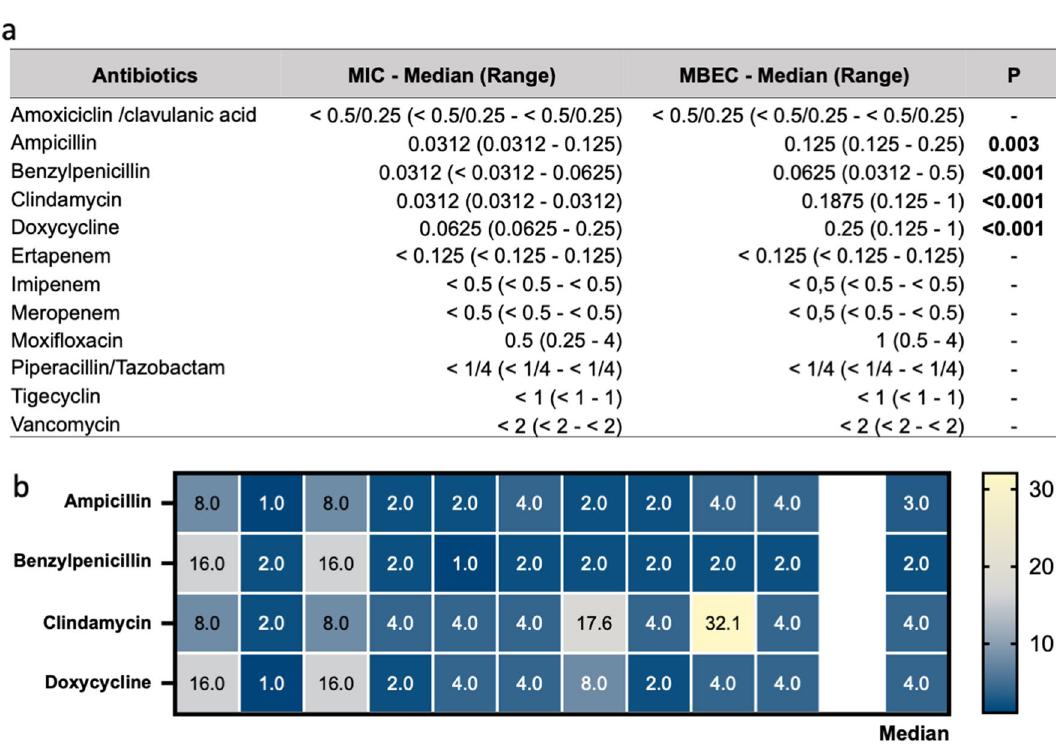
Figure 6. Antimicrobial tolerance in C. acnes isolates. ( a ) Antimicrobial susceptibility testing against ten C. acnes strains (phylotype IA1) isolated from the lesional skin of acne patients in planktonic and biofilm growth measured as minimum inhibitory concentration (MIC) and minimal biofilm eradication concentration (MBEC) for the indicated antibiotics. ( b ) Heat map showing the biofilm tolerance (BT), calculated as the ratio MBEC/ MIC for ampicillin, benzylpenicillin, clindamycin, and doxycycline. Yellow indicates high BT values, and blue represents low BT for the indicated antibiotics. Statistical differences were determined using the Kruskal–Wallis test, followed by Dunn’s post hoc test for multiple